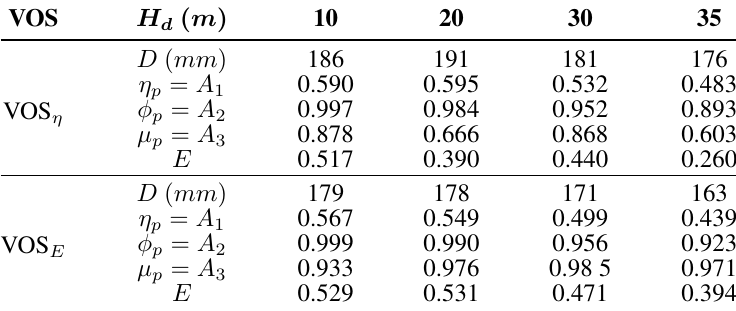
Table 2. VOS results in hydraulic (HR) mode.